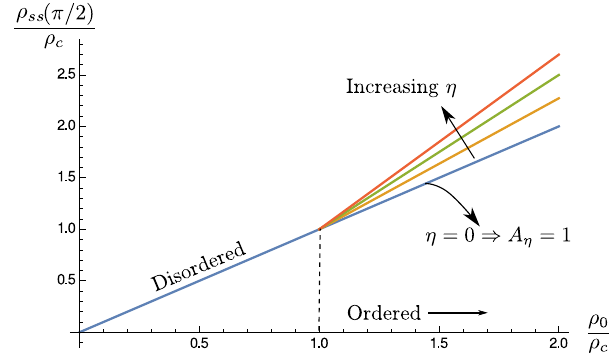
FIG. 2. The peak (maximum) density at the equator on a sphere, as we vary the mean density ρ 0 . For ρ 0 < ρ , we are in the c π = 2 Þ ¼ ρ ρ ρ disordered phase with ρ , we have a 0 . For 0 > ss ð c polar band with the density profile given in Fig. 1. The density reaches its maximum at the center of the band and grows with ρ 0 , with a slope A η > 1 . When the convective parameter λ → 0 , η → 0 , resulting in A → 1 , and we go back to the homogeneous η profile as in the flat plane.